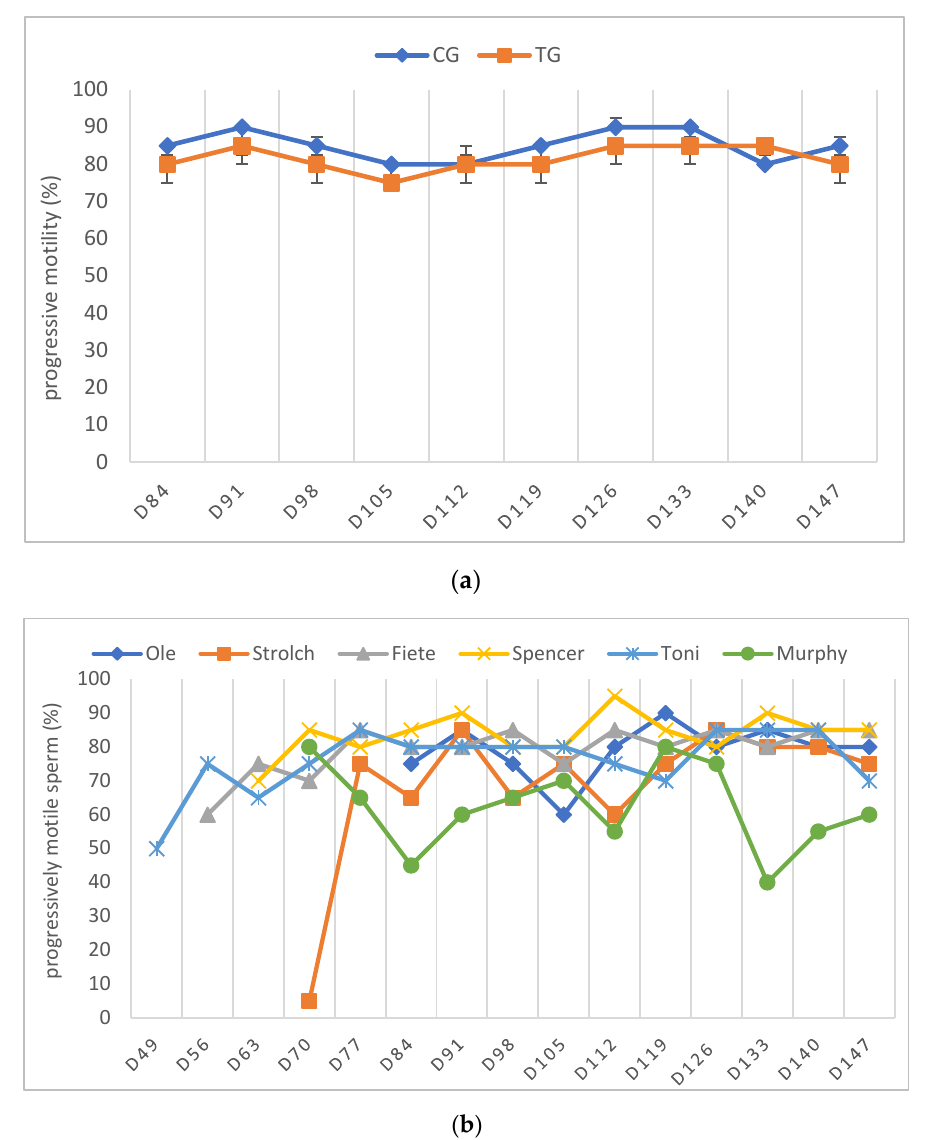
Figure 5. ( a ) Percentage of progressive motility given as median (Q1, Q3) over time of animals treated with a 4.7 mg deslorelin implant (TG, n = 5, excluding Murphy) and saline-treated control animals (CG, n = 3). ( b ) Percentage of progressive motility of spermatozoa given as individual courses of animals treated with a 4.7 mg deslorelin implant (TG, n = 6) over time. In TG, the first spermatozoa were obtained between D49 and 70 after implant removal, whereas the first complete ejaculate analysis was possible between D63 and 91. Expectedly, the semen quality changed variably over time, with VOL and TSC increasing over time. Whereas the percentages of PM and VS barely changed, MAS was increased in the first samples after implant removal but decreased from D112 onwards to approximately 10% at the end of the observation period. Normospermia (5/5) was reached between D84 and 133. Details about the recovery of semen quality by examination day are provided in Supplementary Table